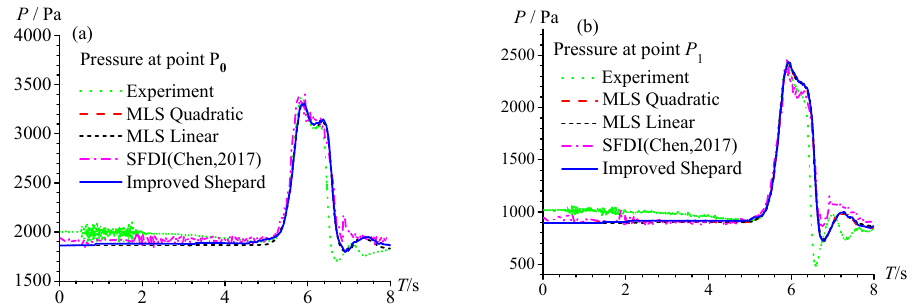
Figure 11. Comparisons of the numerical wave impact pressure time histories with experimental data at P 0 ( a ) and P 1 ( b ).